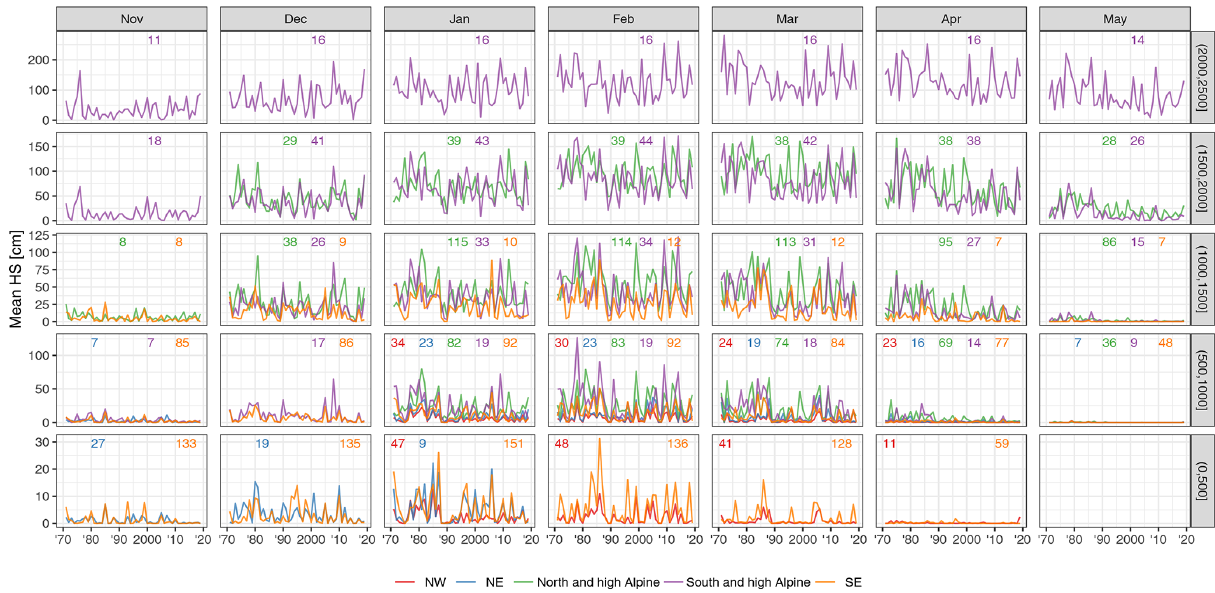
Figure 8. Time series of mean monthly snow depth averaged by 500m elevation bands. The rows indicate elevation band and the columns the months. The small numbers at the top of each panel denote the number of stations included in the average. Lines are only shown if more than five stations were available. Time series of all single stations are available in the repository (Matiu et al., 2020).